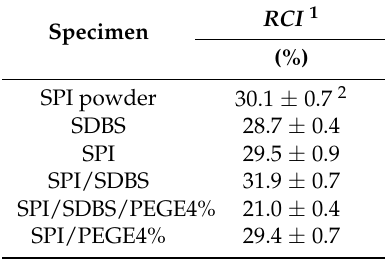
Table 3. Crystallinity of the SPI powder, SDBS and SPI-based films.